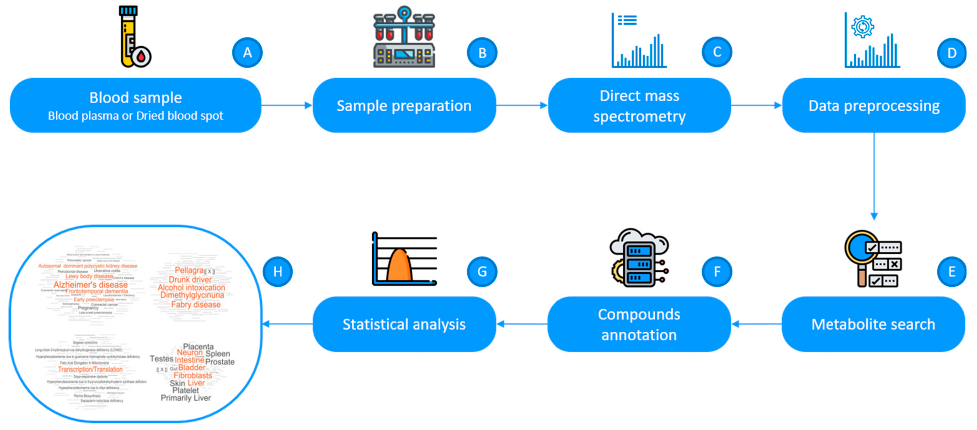
Figure 1. The laboratory-developed test (LDT) workflow. Blood plasma samples (or dried blood spots) are collected ( A ) and transported to the laboratory. In the laboratory, after sample preparation ( B ) and high-resolution direct mass spectrometry ( C ), the mass spectra of the blood plasma samples are obtained. The obtained masses of compounds after preprocessing ( D ) are submitted to the metabolite search block ( E ) to find metabolite identifiers from Kyoto Encyclopedia of Genes and Genomes database (KEGG) database matching the m / z values. Matched KEGG IDs is submitted to a compound annotation algorithm ( F ) [17], and the retrieved results are used for the overrepre- sented metabolite set analysis ( G ). Finally, overrepresented metabolite sets from an individual are visualized as a metabolite set names cloud, where the font size corresponds to the representation value (score) ( H